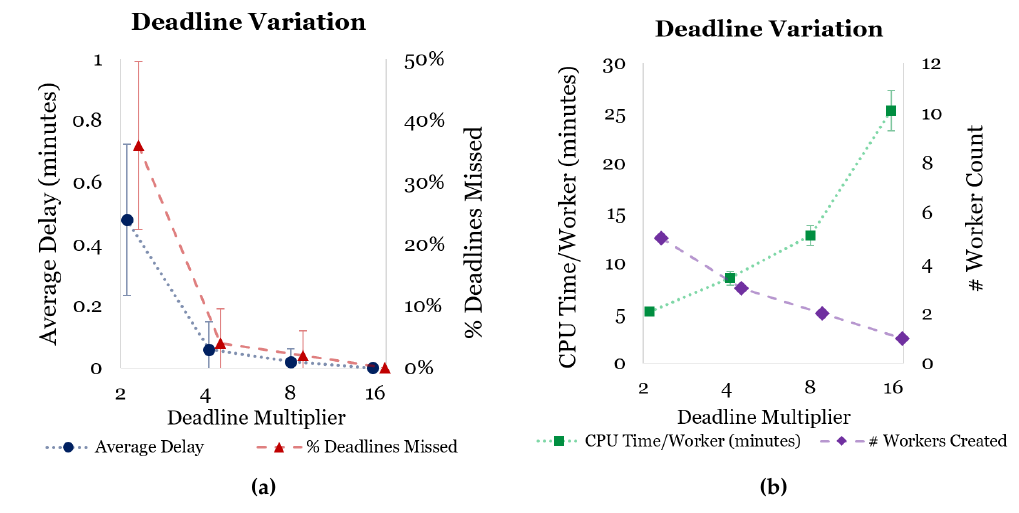
Figure 9. Variation in deadlines. ( a ) Deadline missed; ( b ) resource